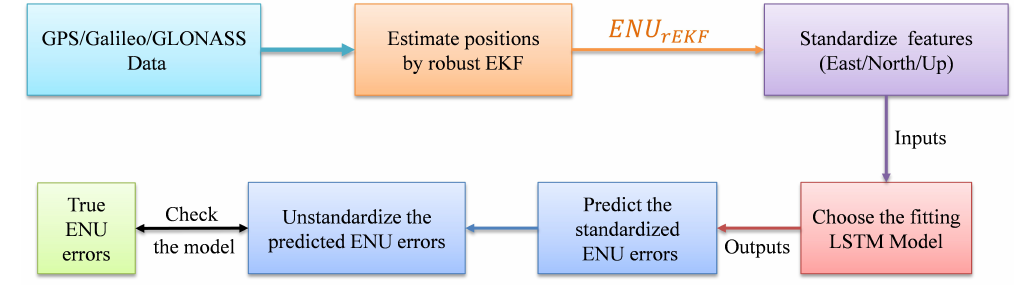
Figure 11. rEKF-LSTM Validation architecture.